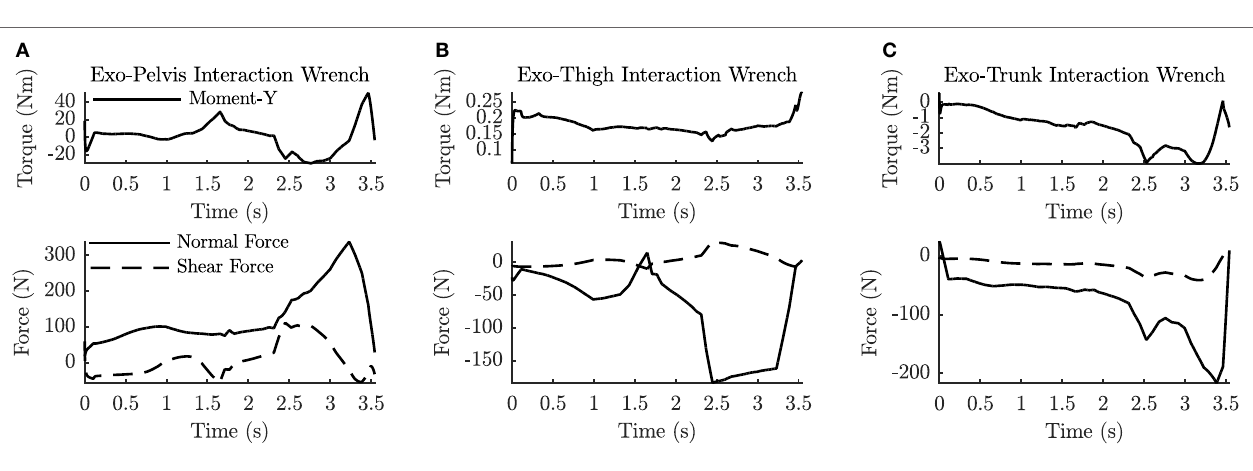
FIgURe 8 | The net human–exo interaction forces and moments at the pelvis (a) , thigh (b) , and trunk (C) for the with-exo